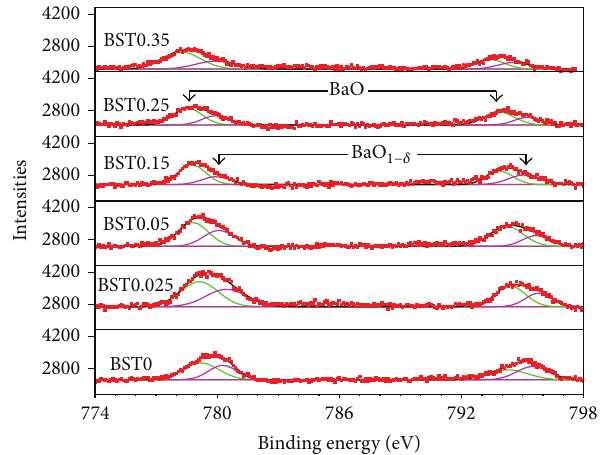
Figure 9: The fitting XPS spectra of Ba 3d deconvolution with Gaussian function.